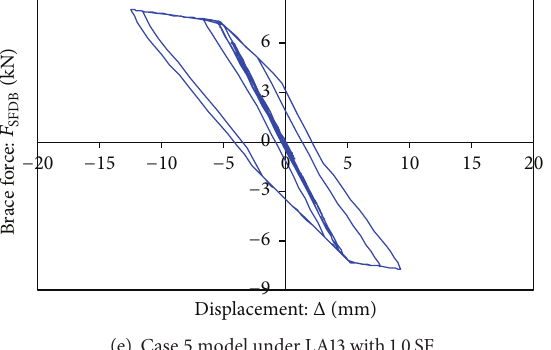
the fundamental period of the SDOF system ( 𝑇 ). This